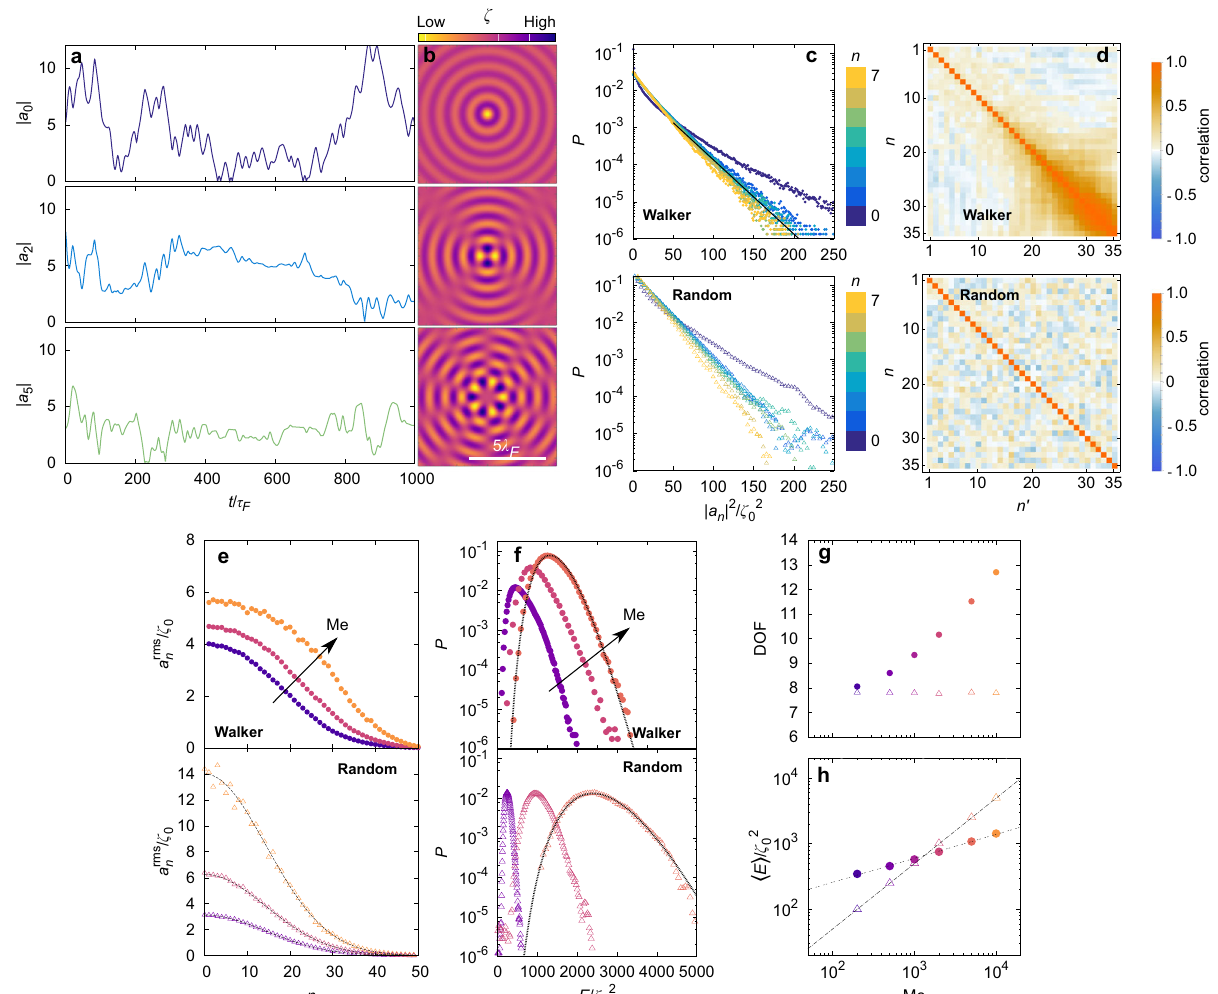
Fig. 2 Statistical description of the numerical dynamics of the wave fi eld. a Numerical time series for ∣ a n ∣ for several different values of n , for memory parameters Me = 1000 and ω /(2 π ) = 0.25 Hz, and ( b ) vizualisation of the real part of the eigenmodes. c Numerical probability density function P that the mode a n takes the value ∣ a n ∣ 2 for a walker (resp. randomly constructed fi eld) for n = 0, … , 7 (from blue to yellow) at Me = 1000 and ω /2 π = 0.25 Hz (logarithmic scale along the y axis). d Correlation matrix for the modes a n for ω /2 π = 0.25 Hz and Me = 1000. Both the random of the walker-generated and randomly-generated wave fi eld are presented. e Numerical root mean squared value (rms) of | a n | as a function of n for memory parameters Me = 500, 2000 and 10,000 (purple, red and orange as indicated by the arrow) in the case of the walker dynamics (resp. randomly constructed fi eld). The theoretical prediction of Eq. (5) is indicated with dotted lines. f Numerical probability density function for the wave intensity E (in semi-logarithmic scale) for the walker dynamics (resp. randomly constructed fi eld). Memory parameters are Me = 500, 2000 and 5000, and they follow the same color code as indicated by the arrow. g Numerical evolution of the number of degree of freedom DOF (Eq. (6)) as a function of the memory parameter for the walker dynamics (full circles) and the random dynamics (empty triangles) in semi-logarithmic scale along the x axis. h Comparison of the evolution of the average wave fi eld intensity 〈 E 〉 with Me, between the walker wave fi eld (full circles) and the random wave fi eld (empty triangle) in double logarithm scale. Dashed lines are power laws fi tted to the simulation data. For the walker, the exponent obtained from a power law fi t and is 0.382 ± 0.024 (error is the 95%-con fi dence interval, coef fi cient of determination R 2 = 0.9997). For the random fi eld, the exponent is 0.991 ± 0.007 (95%-con fi dence interval, R 2 =